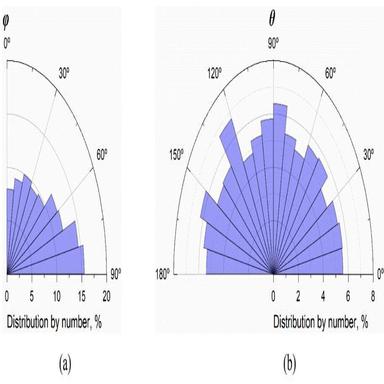
Statistics of particle orientation in terms of (a) polar angle φ and (b) azimuthal angle θ of the long axis of the particles extracted from μXCT results.